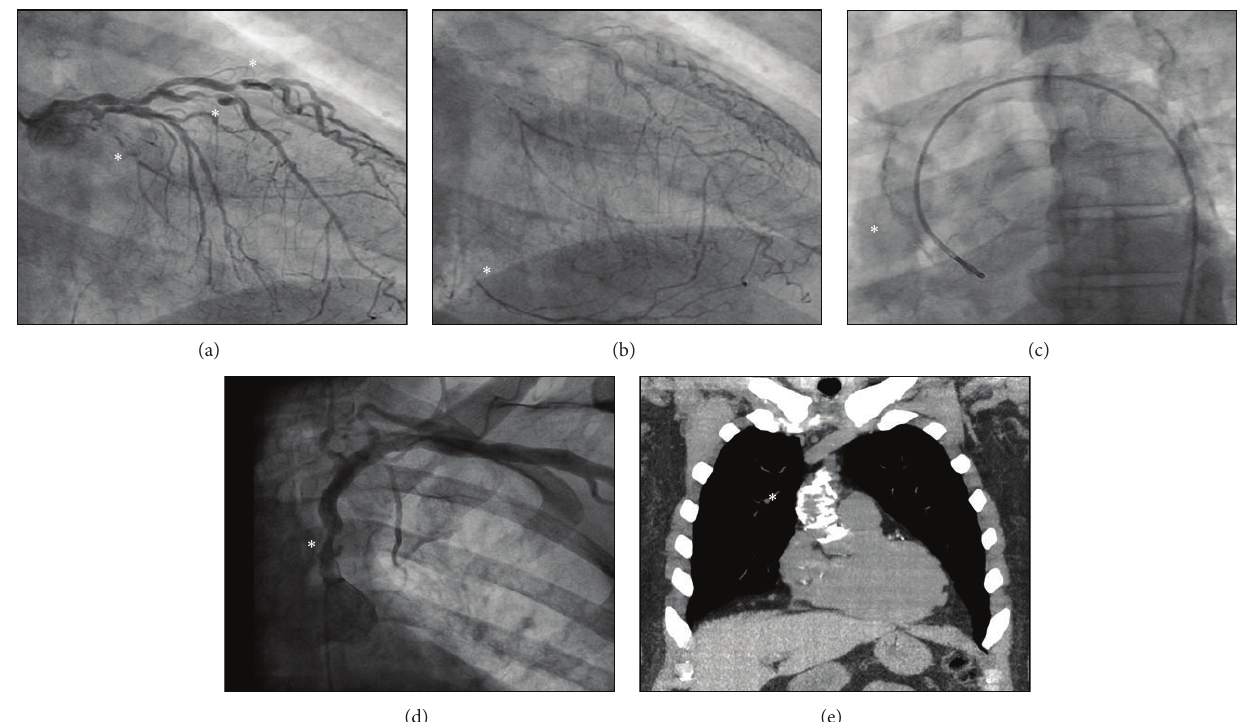
Figure 1: Cardiac catheterization shows multivessel coronary artery disease with occluded left circumflex artery as well as high-grade lesions of the left anterior descending artery and diagonal arteries (a). In addition, delayed imaging shows occluded right coronary artery filling via left-to-right collaterals (b). Cardiac catheterization (c) shows a heavily calcified ascending aorta as well as left subclavian artery stenosis (d). Noncontrast computed tomography of the chest again shows a heavily calcified ascending aorta (e). All lesions are represented with “ ∗